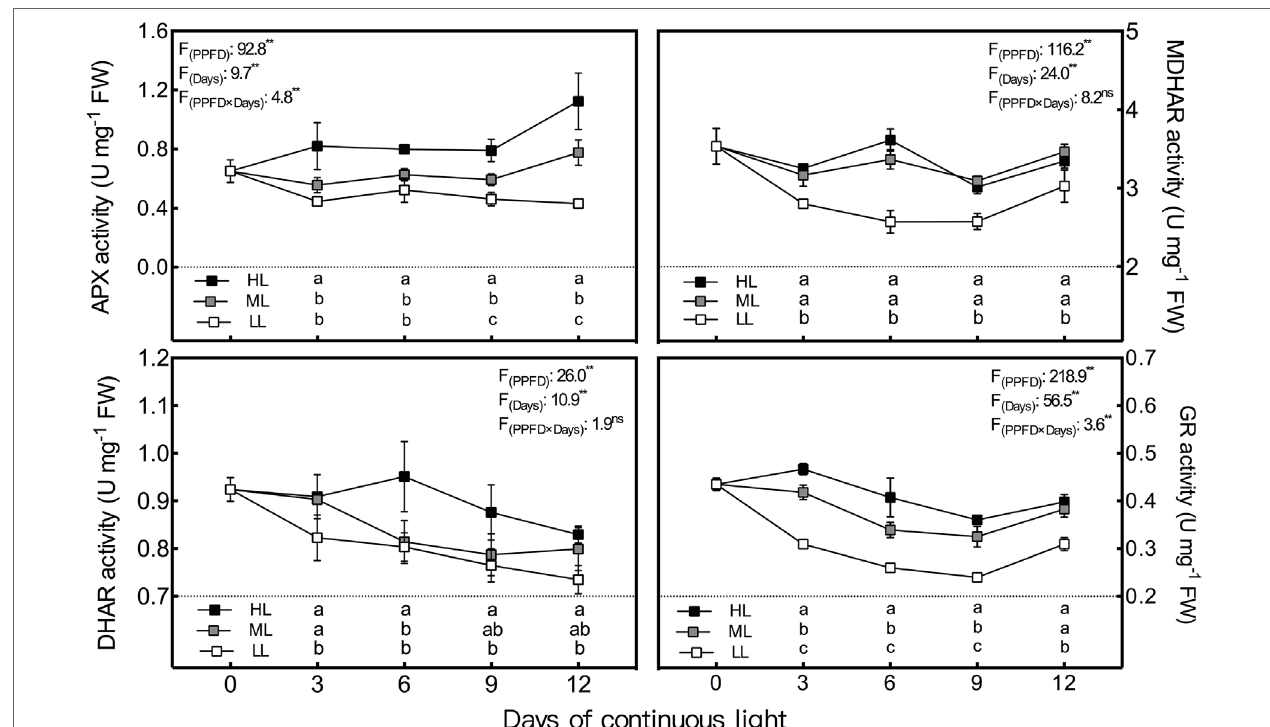
FIgURe 5 | Changes in ascorbate peroxidase (APX), dehydroascorbate reductase (DHAR), monodehydroascorbate reductase (MDHAR) and glutathione reductase (GR) activities in lettuce leaves grown under continuous light of different intensities: low light (LL, 100 μmol·m −2 ·s −1 ), medium light (ML, 200 μmol·m −2 ·s −1 ), and high light (HL, 300 μmol·m −2 ·s −1 ). Values are means of four replicates ± SD. Different letters indicate significant differences between different light intensity treatments at p < 0.05 according to Tukey test. F values and significance of the two-way ANOVA considering the factors light intensity (PPFD), days and their interactions were given in the inset. ns and ** indicate nonsignificant and significant at p < 0.05 and 0.01 respectively.